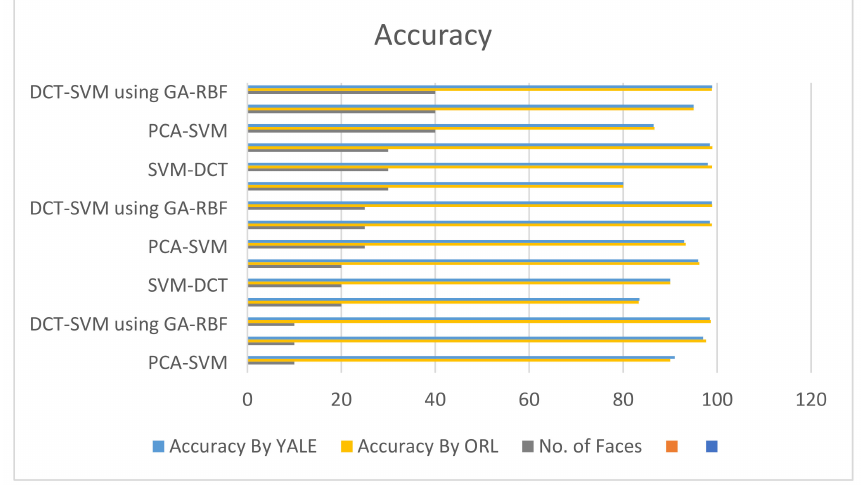
Figure 7. Accuracy vs. number of faces.